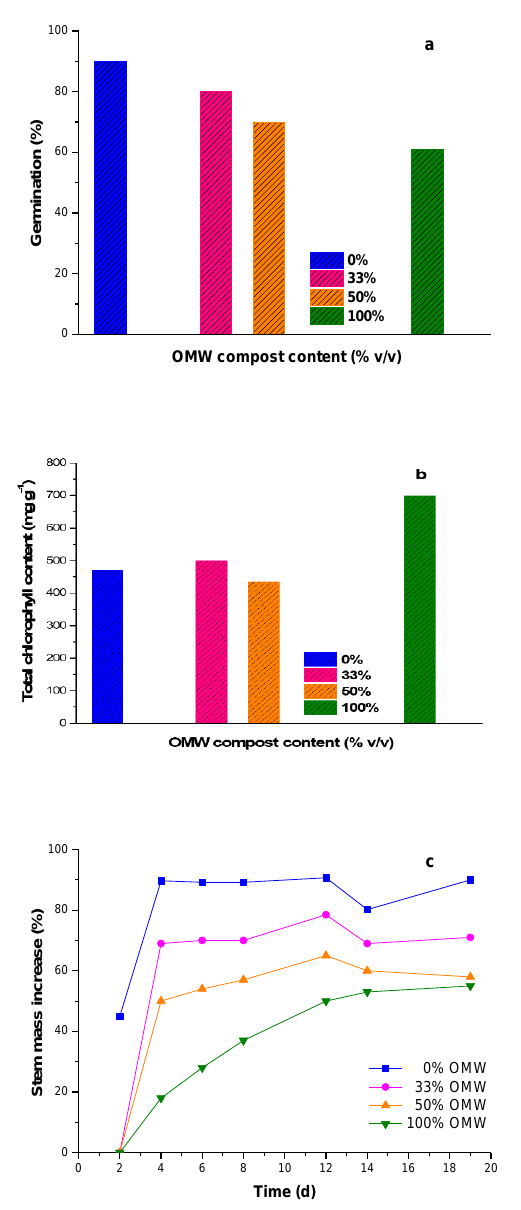
Figure 6. Germination ( a ), total chlorophyll content ( b ), and growth rate ( c ) of Lactuca sativa L. in substrates with different OMW biotreatment contents.